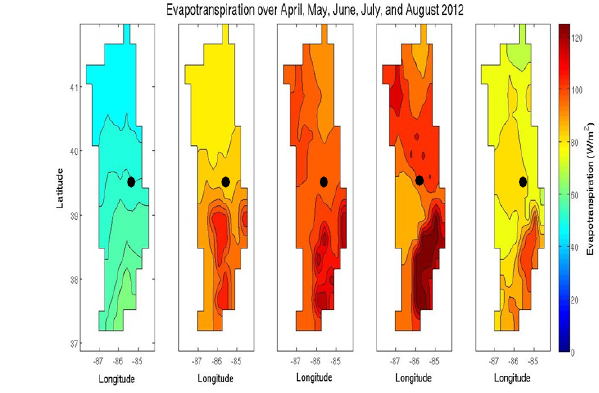
Figure 4: Spatiotemporal changes in ET over the spring and summer of 2012. The black dot represents the location of Indianapolis, IN.